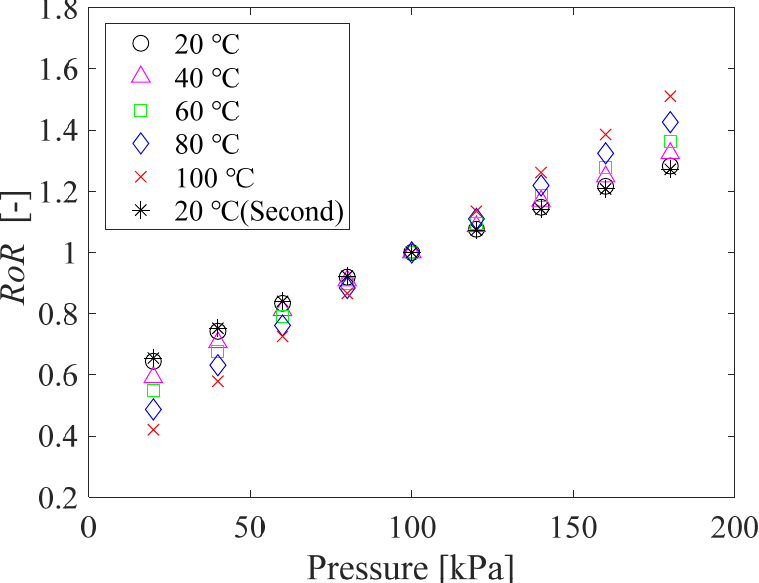
Figure 12. The relationship between the pressure and the RoR of PC-PSP with 0.5 g of urethane resin.